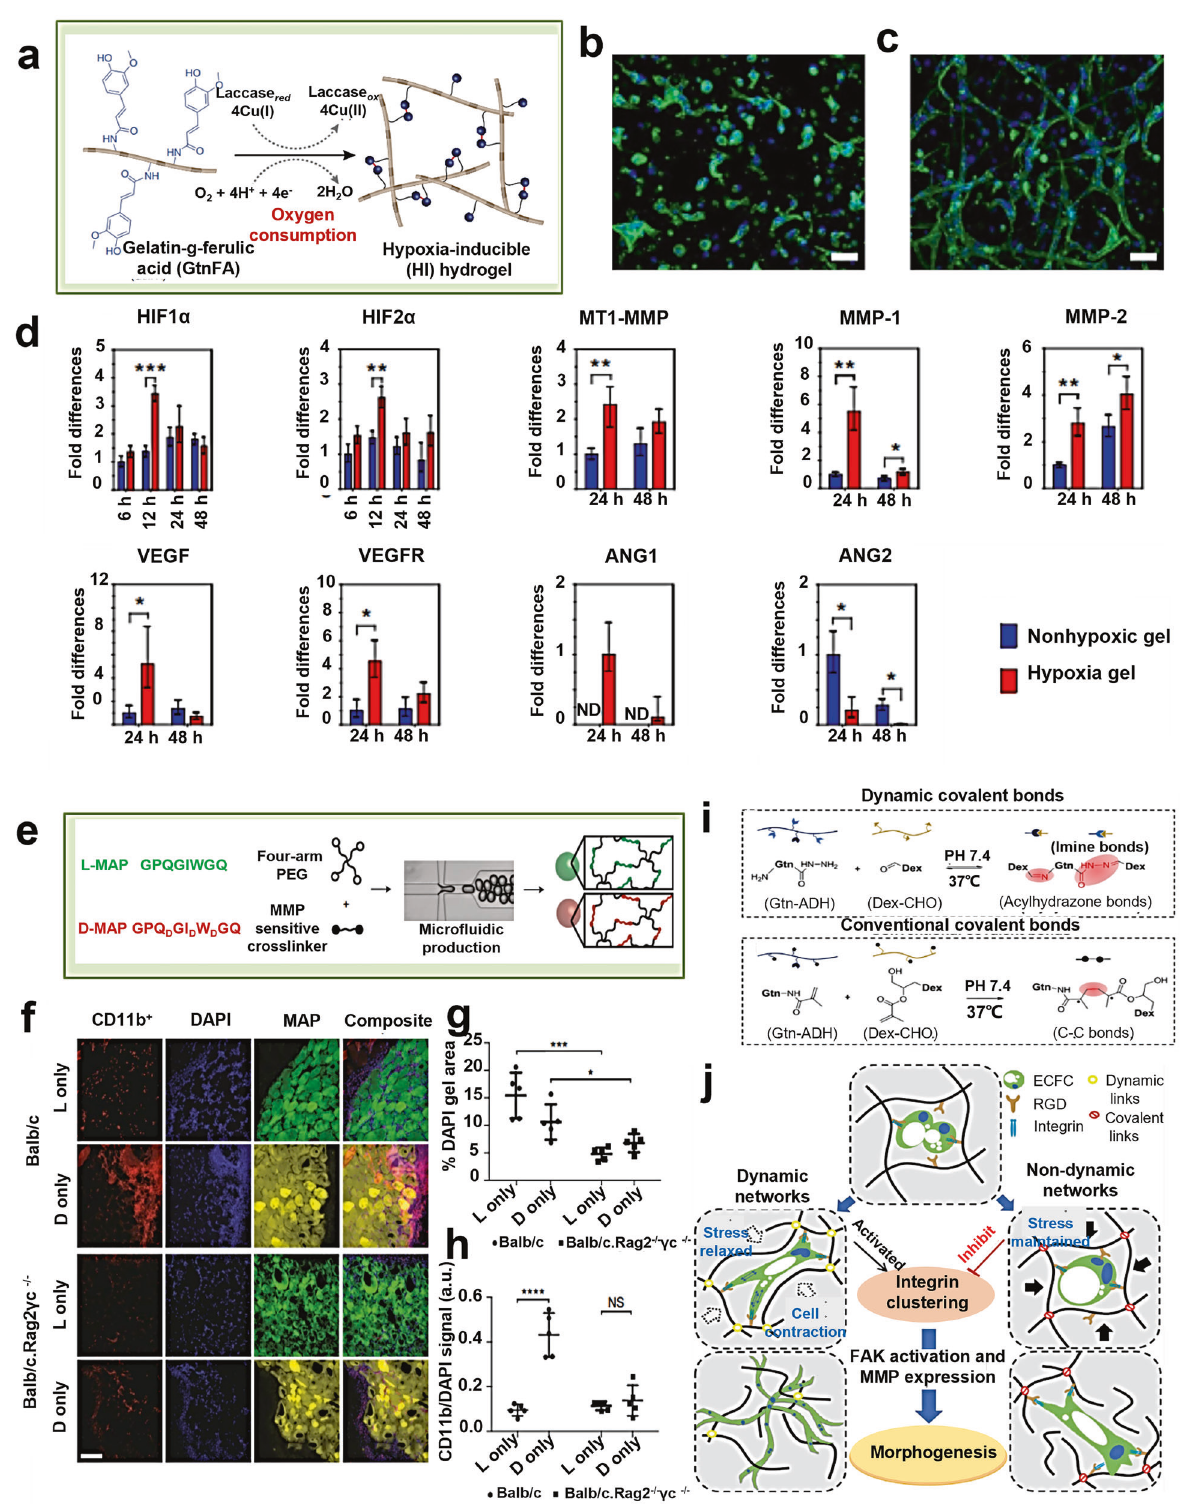
Fig. 9 The effects of other hydrogel properties on cell biology and biomedical applications. a – d Hypoxia-inducible hydrogel design ( a ) could enhance blood vessel morphogenesis ( b , c ) with increased correlated gene expression levels ( d ). * p < 0.05, ** p < 0.01 and *** p < 0.001. Reproduced with permission. 295 Copyright 2014, Springer nature. e – h D- and L-chiral hydrogel preparation ( e ) and the induced immuno-responses ( f – h ), where hydrogels with D-chirality induced adaptive immune responses with CD11b + myeloid cell recruitment compared to the L-chiral hydrogel in mice. ( g * p = 0.0455, *** p = 0.0006; h **** p < 0.001). Reproduced with permission. 297 Copyright 2020, Springer nature. i , j Self-healing hydrogel construction ( i ) and the enhanced angiogenesis via a series of signaling cascades, including integrin clustering, FAK activation, and MMP expression ( j ). Reproduced with permission. 145 Copyright 2020, Elsevier